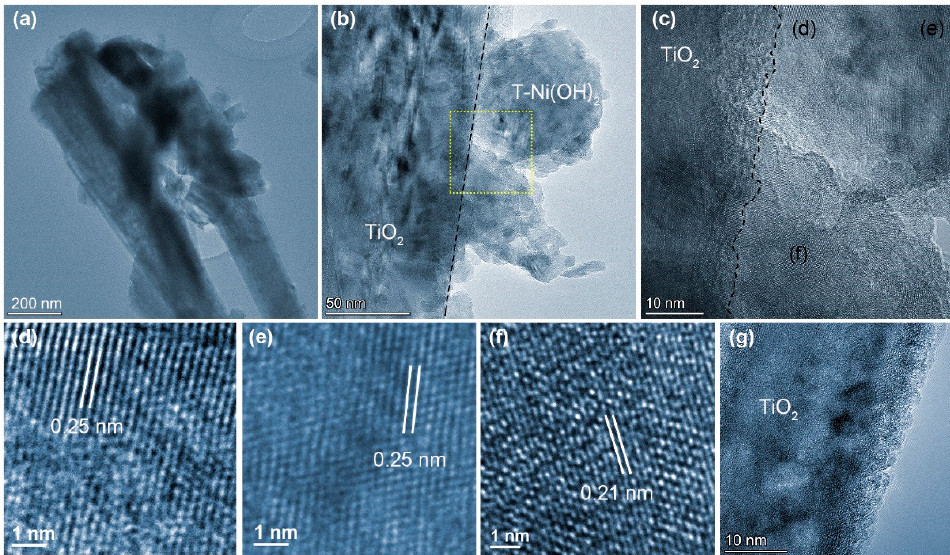
Figure 4. ( a , b ) Low-magnification TEM images of T-Ni(OH) 2 @TiO 2 . ( c – f ) High-magnification TEM images of T-Ni(OH) 2 @TiO 2 . ( g ) TEM image of T-Ni(OH) 2 @TiO 2 in the region of bare TiO 2 .